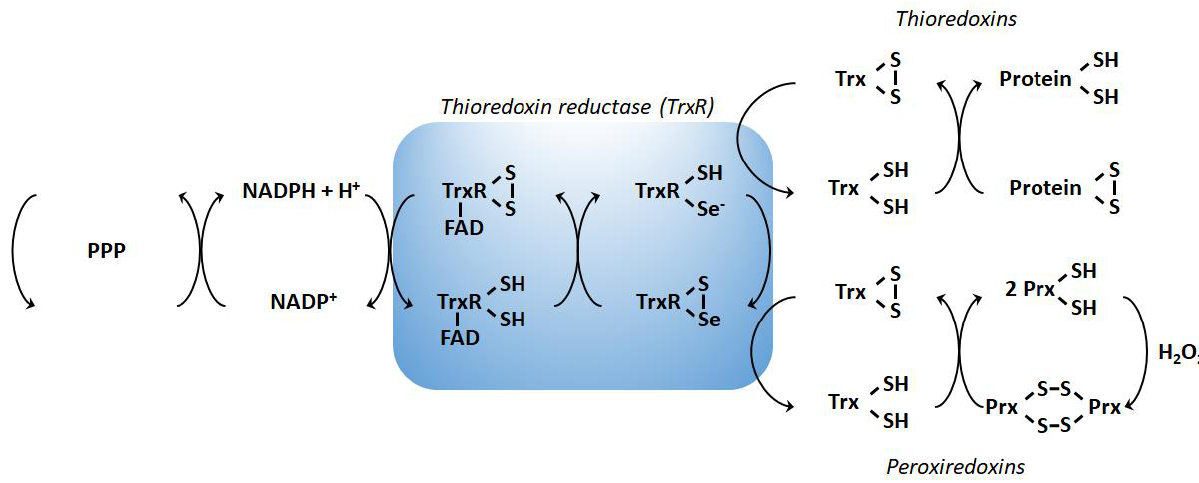
FIGURE 2: The arsenal of mitochondrial antioxidant defenses comprises the thioredoxin and peroxiredoxin pathways. The image depicts redox reactions catalyzed by the thioredoxin and peroxiredoxin systems, comprising thioredoxin reductases (TrxR, of which ThxR2 is ex- pressed in mitochondria), thioredoxins (Trx), peroxiredoxins (Prx) and NADPH. The electron source is NADPH, which mostly originates from the pentose phosphate pathway (PPP). Oxidized thioredoxins (Trx-S2) are reduced by NADPH and selenoenzymes TrxRs. Electrons are se- quentially transferred from NADPH to FAD, to the N-terminal redox active disulfide in one subunit of TrxR, and, finally, to the C-terminal active site of another subunit. Reduced thioredoxins (Trx-SH 2 ) catalyze disulfide bond reduction in many proteins, including Prxs, thus ensur- ing oxidative damage repair in proteins as well as H 2 O 2